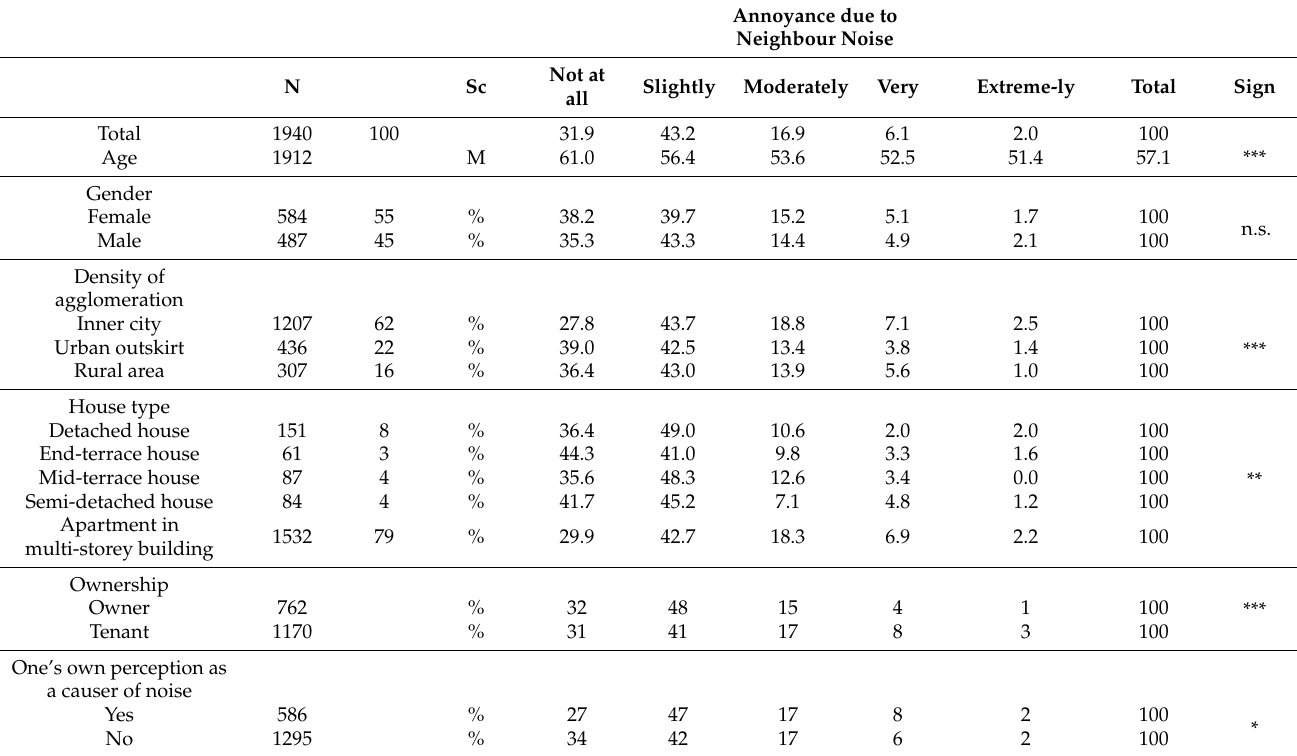
Table 1. Descriptions by annoyance levels (five-point verbal scale levels).